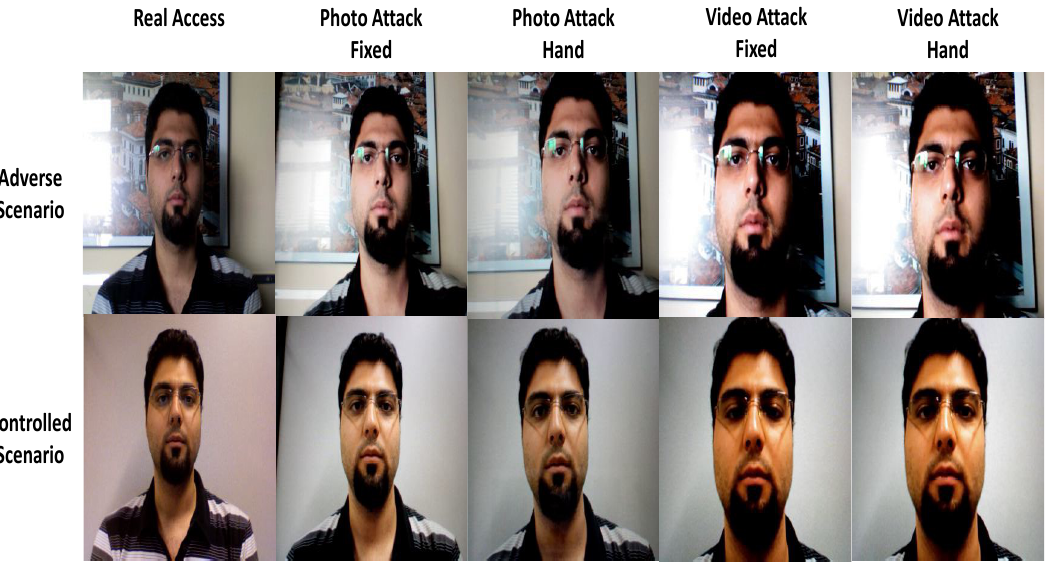
Figure 4. Examples of real accesses and attacks in different scenarios.